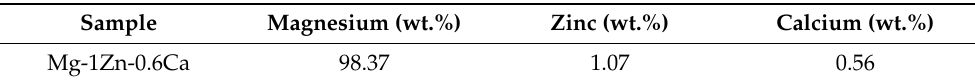
Table 1. Nominal and actual composition of Mg-Zn-Ca alloy using X-ray fluorescence (Bruker S8 Tiger, Billerica, MA, USA) analysis. Sample Magnesium (wt.%) Zinc